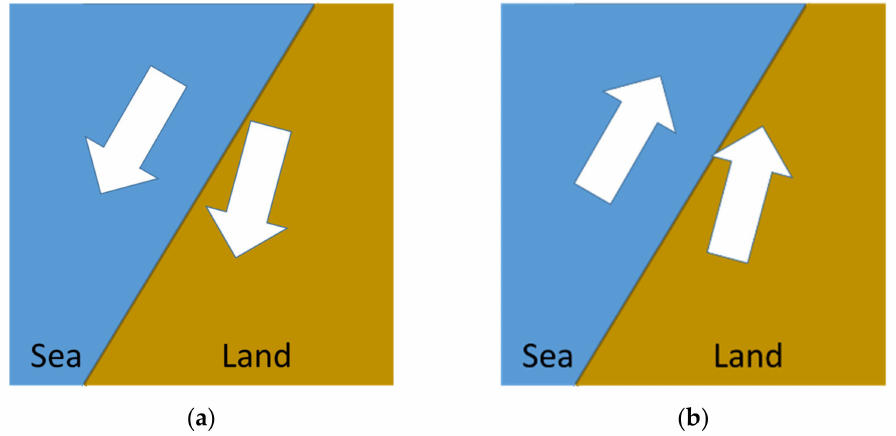
Figure 4. ( a ) Corkscrew sea breeze. White arrows denote PW. ( b ) Backdoor sea breeze. White arrows denote